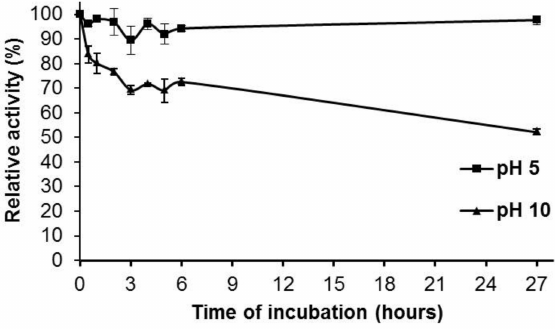
Figure 4. Stability of the purified Pc Xyn11A at pH 5.0 and 10.0 at room temperature measured under a standard enzyme assay condition.